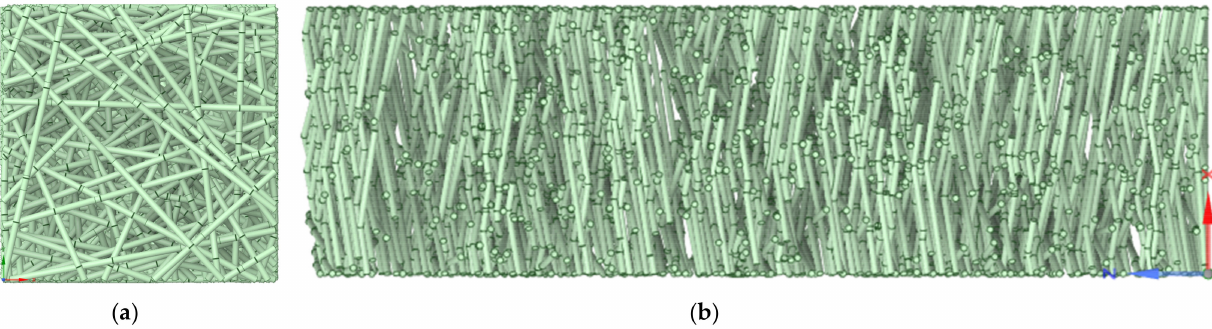
Figure 11. Digital twin HEPA filter built to 320 Pa flow resistance. ( a ) Top view of face area perpendicular to flow. ( b ) Side view showing filter thickness.